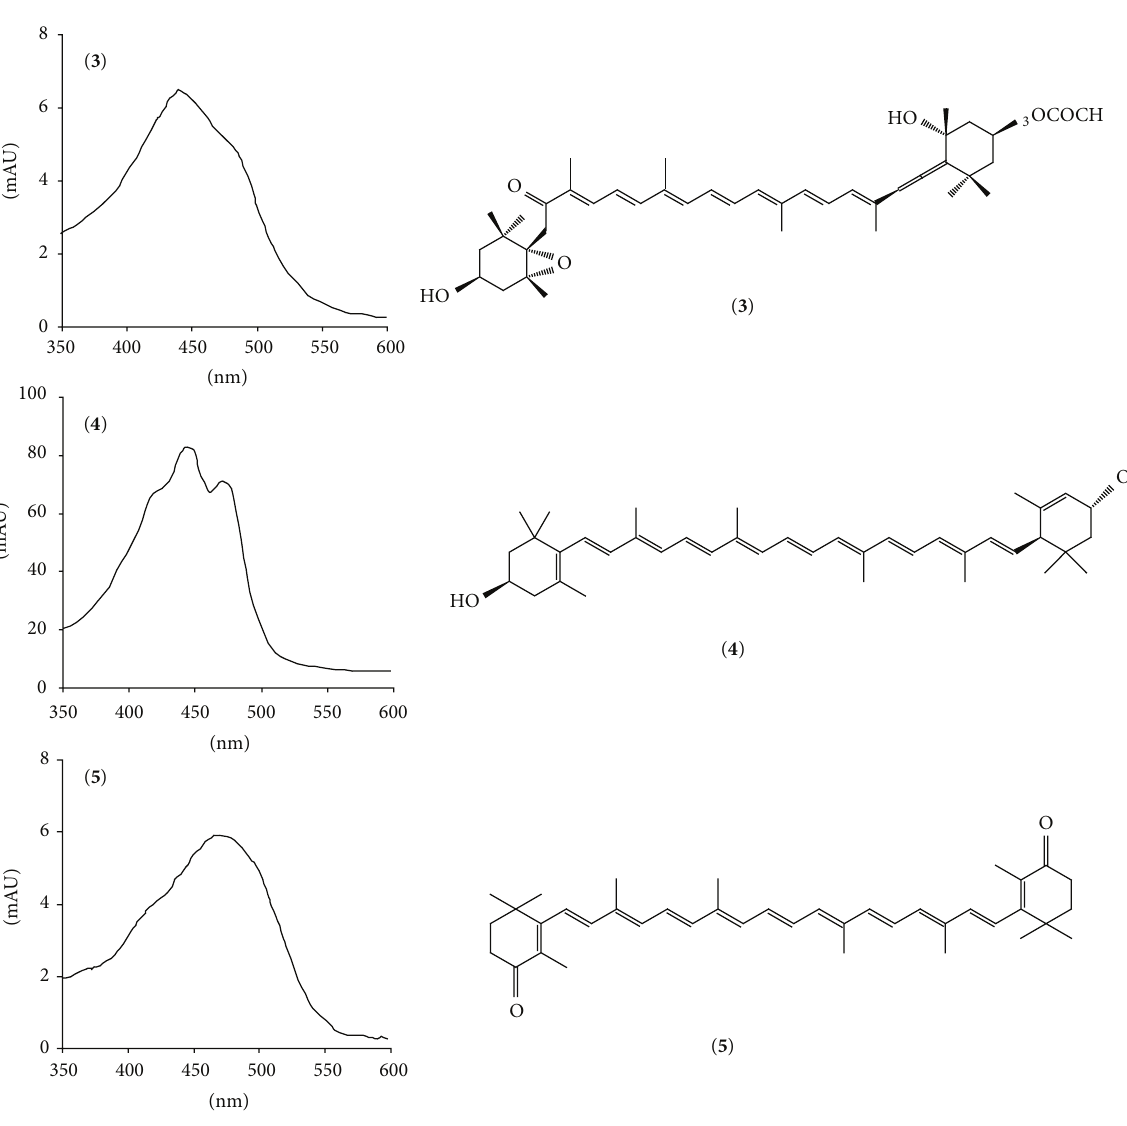
Figure 7: UV-vis spectra of fucoxanthin ( 3 ), lutein ( 4 ), and canthaxanthin ( 5 ).